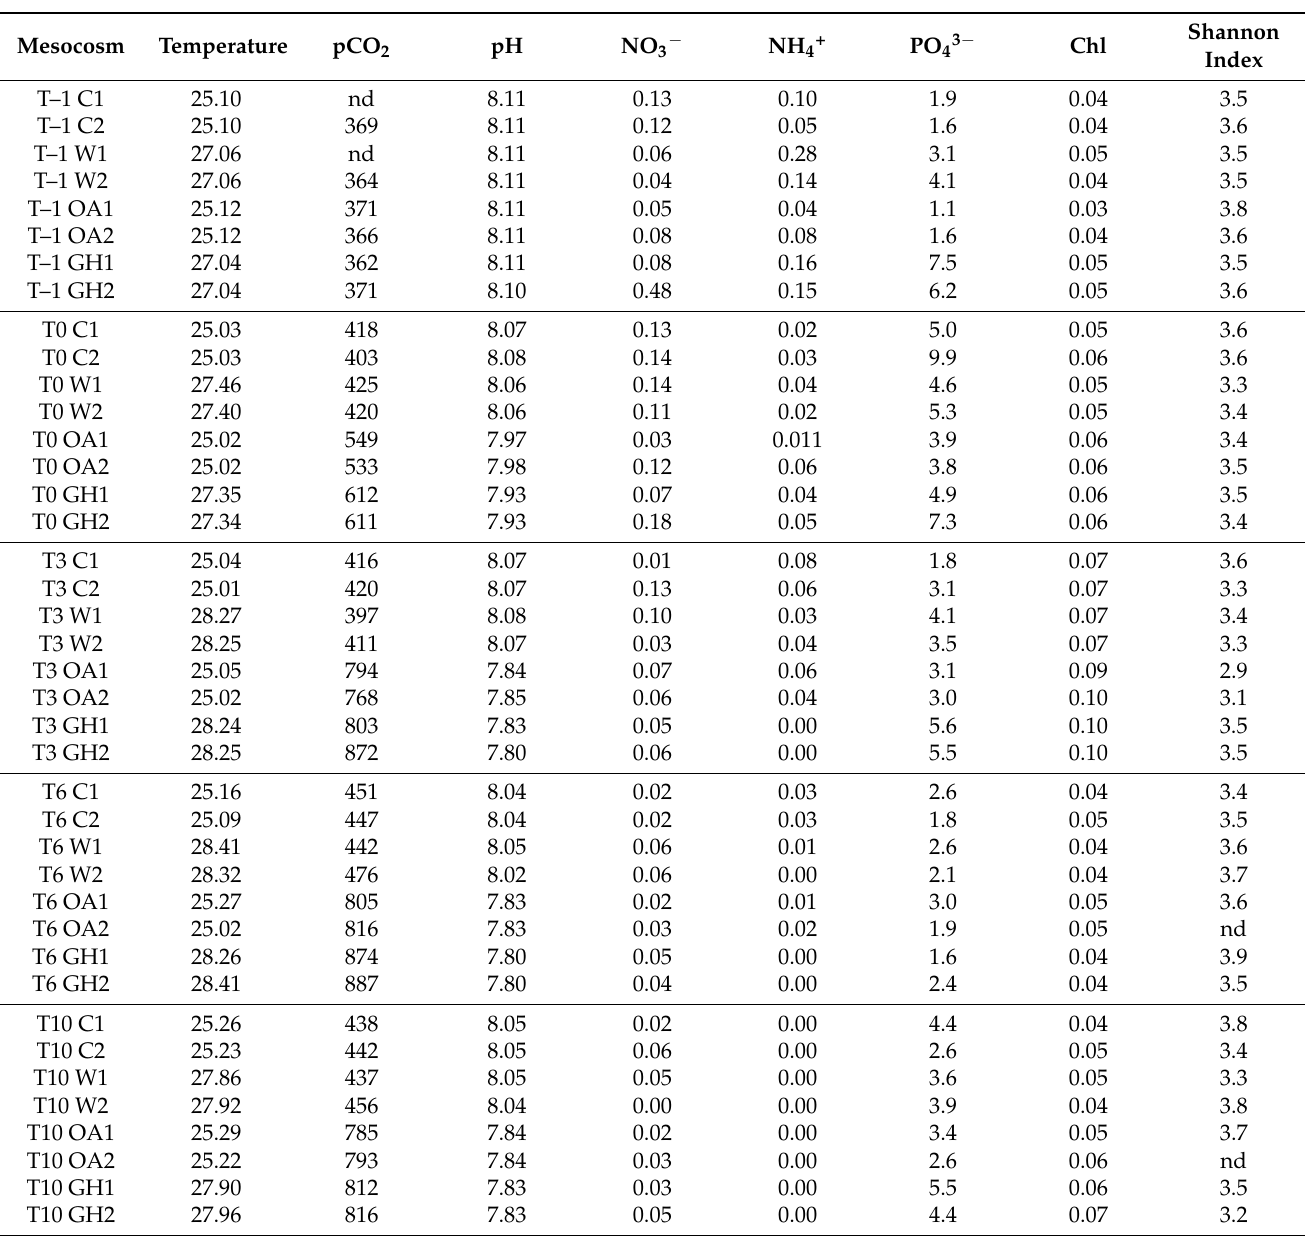
Table 1. Temperature ( ◦ C), pCO 2 ( µ atm), pH, the concentrations of the inorganic nutrients NO 3